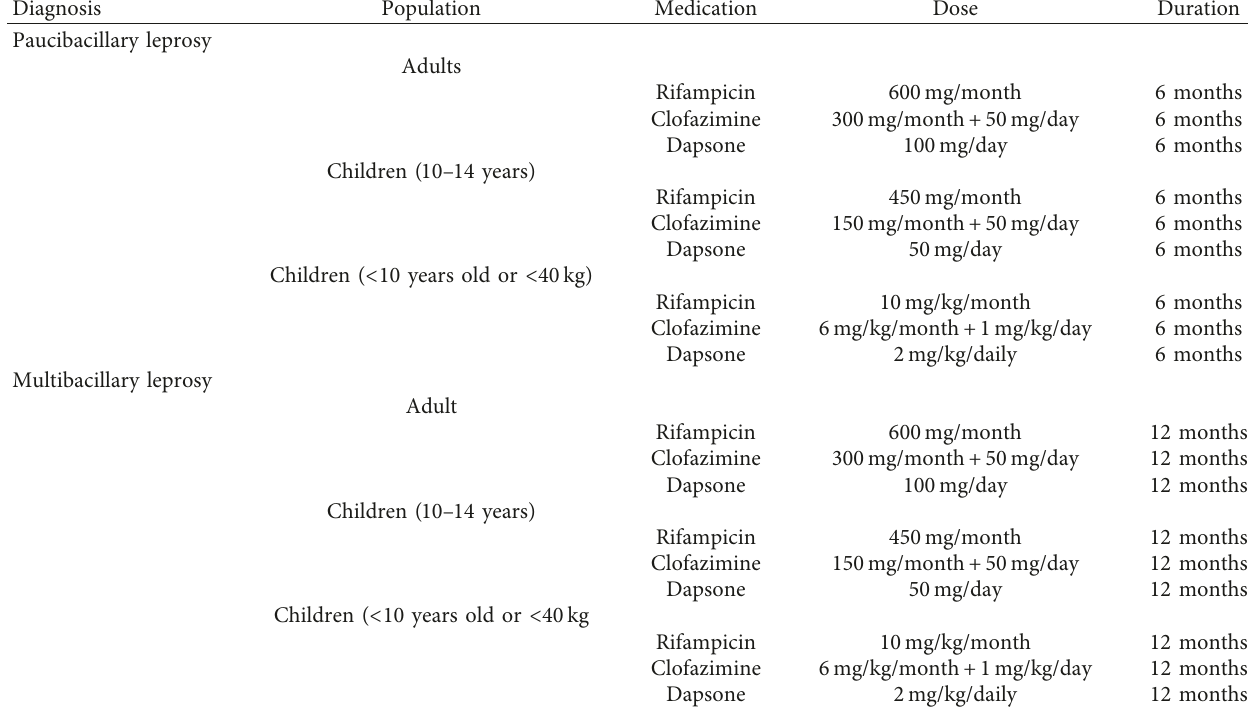
Table 3: Summarized the treatment regimen recommended from World Health Organization.